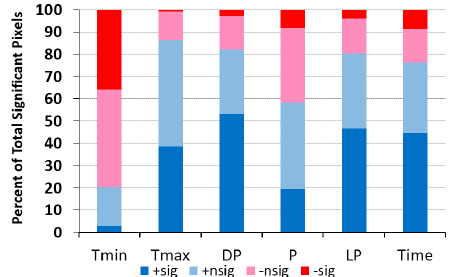
Figure 3. Summary of relationship direction and significance level between the NDVI and climatic factors and time in multivariate autoregression analyses (Equation (4)) for ~7,660,636 1 km × 1 km pixels in USA. Factors are average monthly minimum temperature (Tmin), maximum temperature (Tmax), dew point temperature (DP), precipitation (P), previous month’s precipitation (Lag[Prcp]), and time. Data are summarized for pixels with significantly ( p < 0.05) positive association between the NDVI and the subject factor (+sig), not significant positive association (+nsig), not significant negative (-nsig) association, and significant negative (-sig) association.